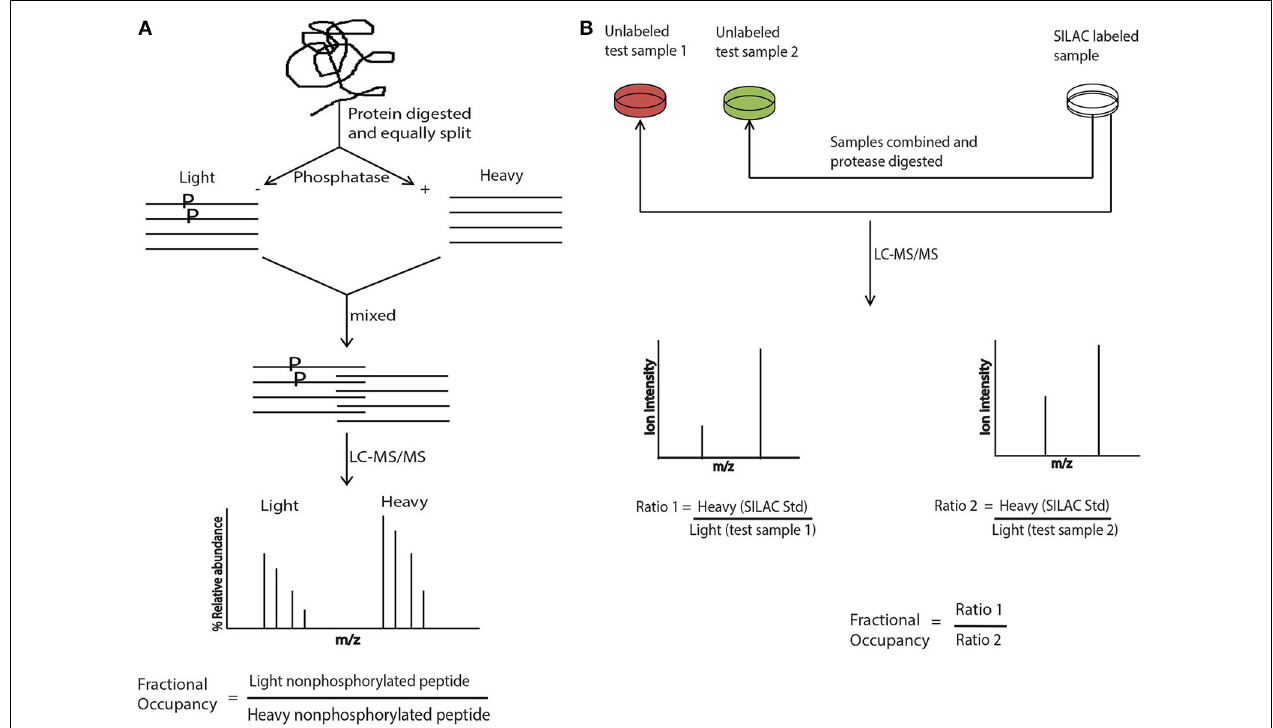
FIGURE 1 | Absolute quantitation with stable isotope labeling and SILAC. (A) Protein is digested with a proteaseand divided equally into two aliquots. One aliquot is treated with phosphatase and exposed to heavy isotope and the other aliquot is mock treated and exposed to light label. The two aliquots are combined and subjected to LC-MS/MS analysis. The phosphorylation site occupancy is calculated by taking a ratio of relative abundance of non-phosphorylated light peptide vs. non phosphorylated